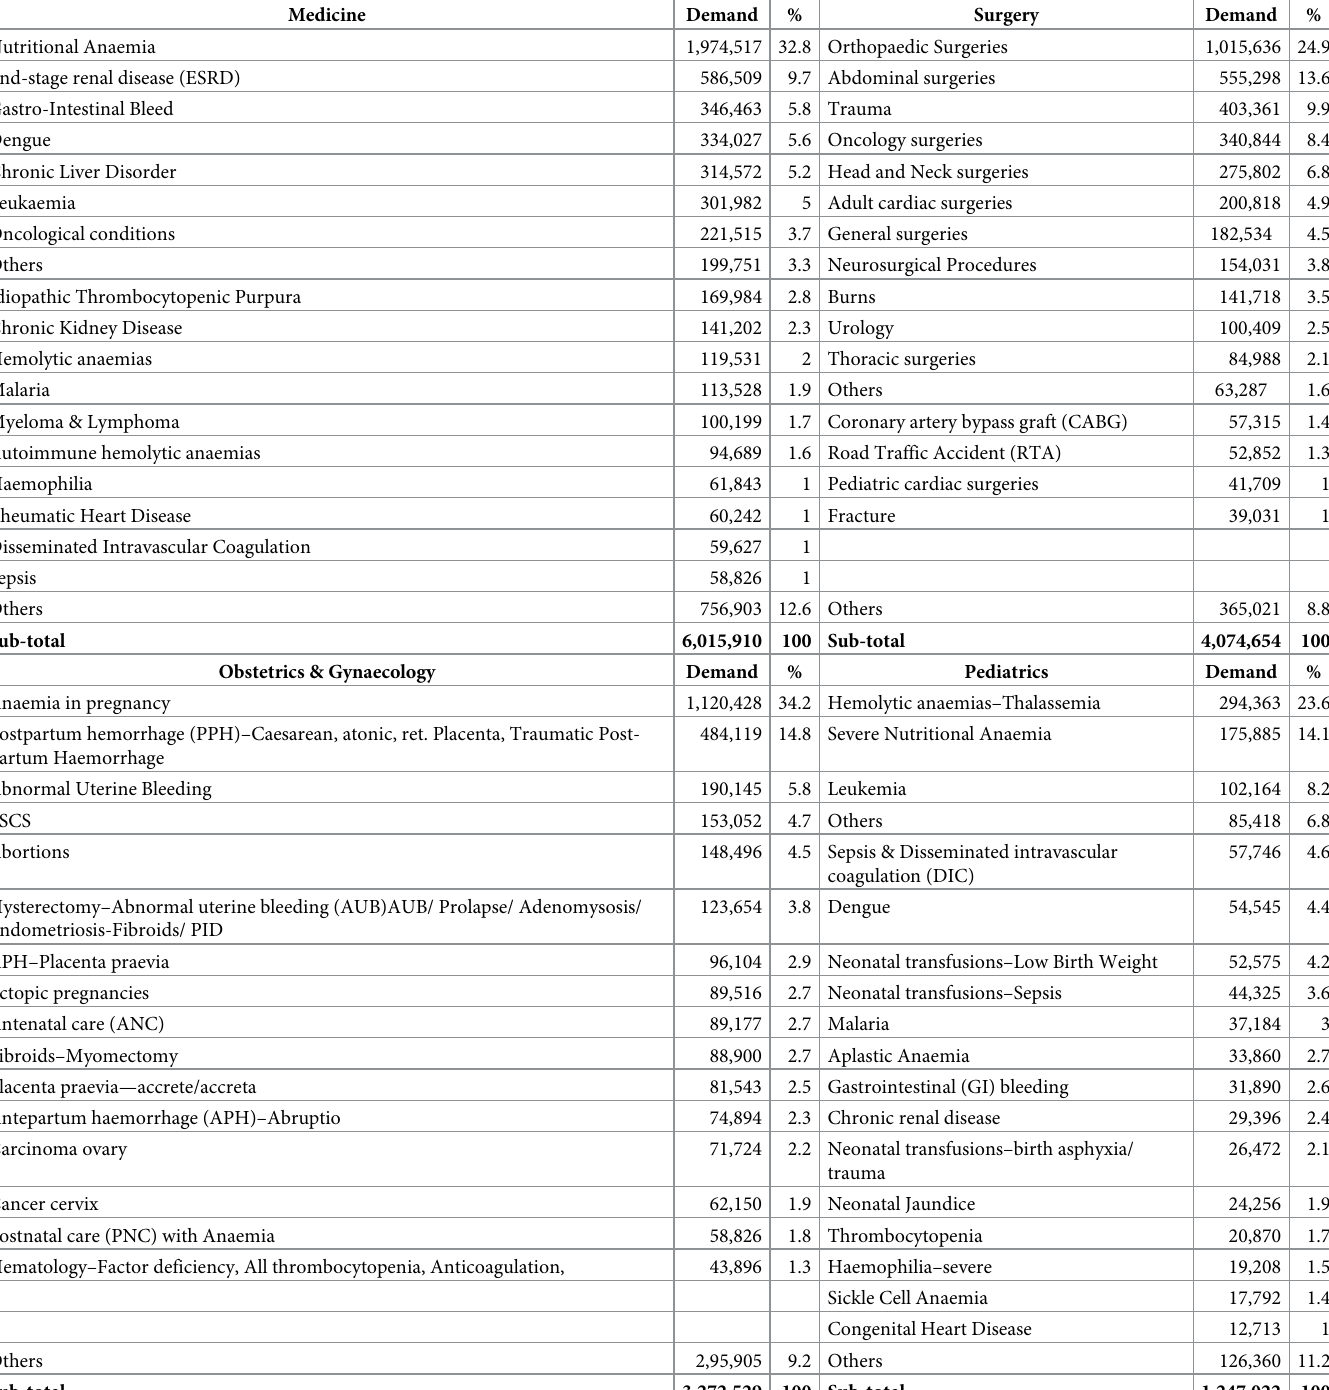
Table 4. Major contributors of demand—medicine, surgery, obs & gyn and paediatrics (whole blood units).